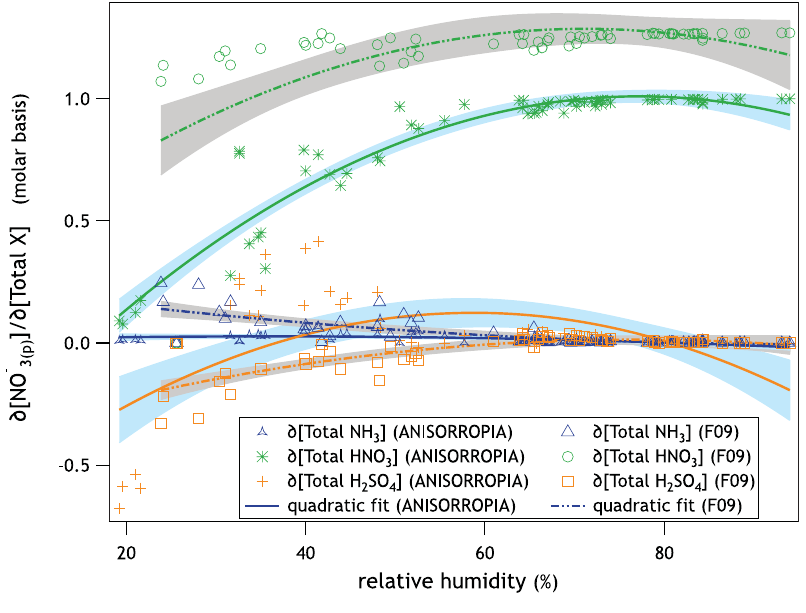
∂ [ NO − ∂ NO − ∂ NO − 3 ( aq ) 3 ( aq ) 3 ( aq ) Fig. 9. The ANISORROPIA-produced , , and values are plotted alongside backward finite difference ∂ [ TotalHNO 3 ] ∂ [ TotalNH 3 ] ∂ [ TotalH 2 SO 4 ] sensitivities from Fountoukis et al. (2009) (F09) for MILAGRO observations in Mexico City. The quadratic fits to the sensitivity data are shown to direct the eye with the 95% confidence interval given by the shaded bands about the fit lines. Solid lines and light blue shading correspond to ANISORROPIA sensitivities; dashed lines and gray shading correspond to F09 sensitivities. With the exception of the fit about ∂ NO − 3 ( aq ) , ANISORROPIA has tighter bands than F09, indicating less scatter in the results due to the direct computation of sensitivity ∂ [ TotalH 2 SO 4 ] about the desired input. ANISORROPIA characterizes the sensitivity of Mexico City aerosol nitrate similarly to the full forward model employed by